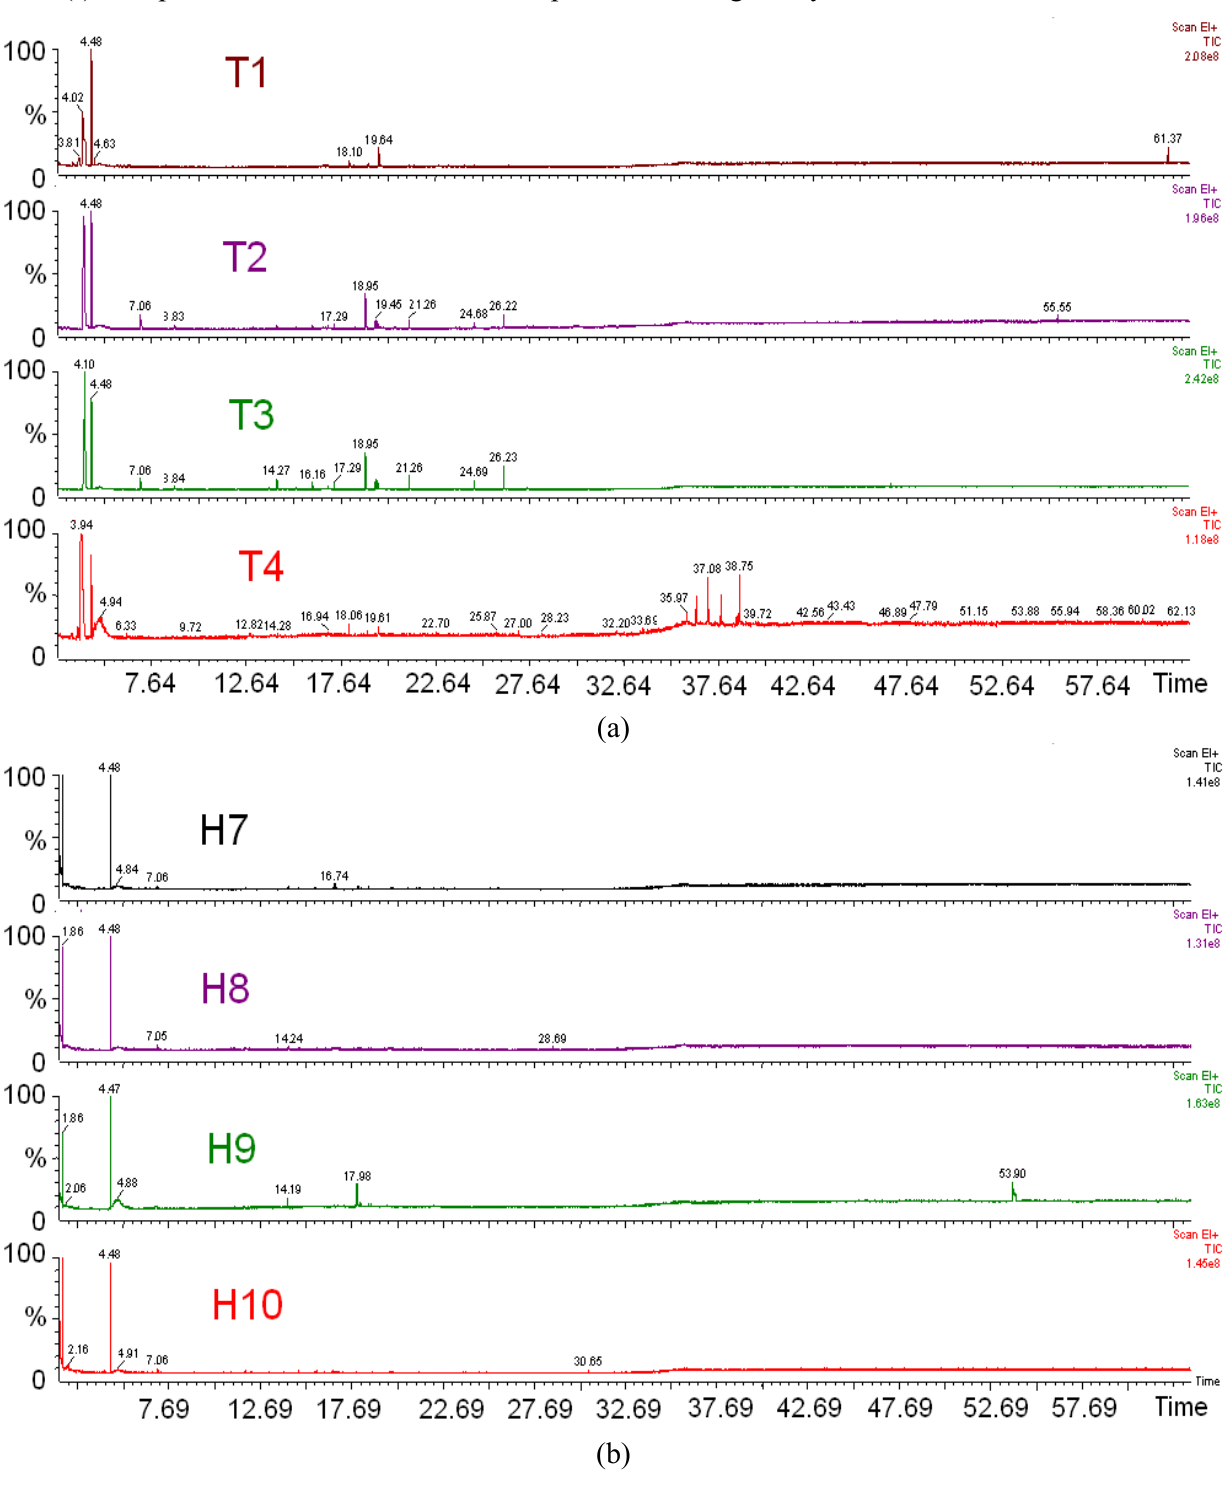
Figure 4. The chromatograph results of the selected monofloral honeys, polyfloral honeys, sugar and adulterated samples: ( a ) Four different brands of Tualang Honey, ( b ) Four different monofloral Honey from New Zealand, ( c ) Six different monofloral honey from Malaysia, ( d ) Comparison between monofloral and polyfloral honey, ( e ) Comparison between polyfloral and monofloral honey samples with two different brands sugar syrup, ( f ) Comparison between adulterated sample and Tualang